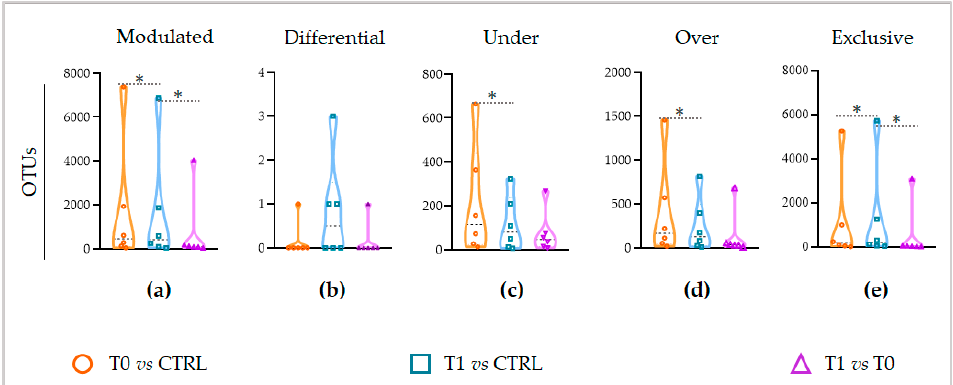
Figure 4. The modulation trends of OTUs in compared microbiota. The number of ( a ) modulated, ( b ) differential, ( c ) under and ( d ) over-represented, and ( e ) exclusive OTUs is reported with respect to each compared microbiota. The orange and blue colors indicate the OTUs of T0 and T1 microbiota compared to the CTRL ones. The violet color depicts the OTUs varied in the T1 microbiota with respect to the T0 microbiota. The asterisk indicates the statistical significance of comparisons, with * standing for p < 0.05.